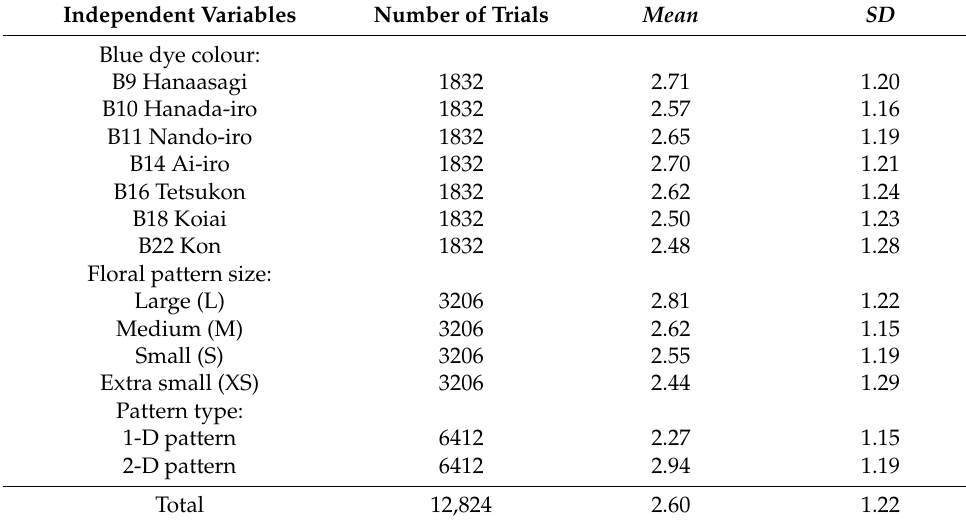
Table 2. Mean preference for each independent variable (subjects n = 229).